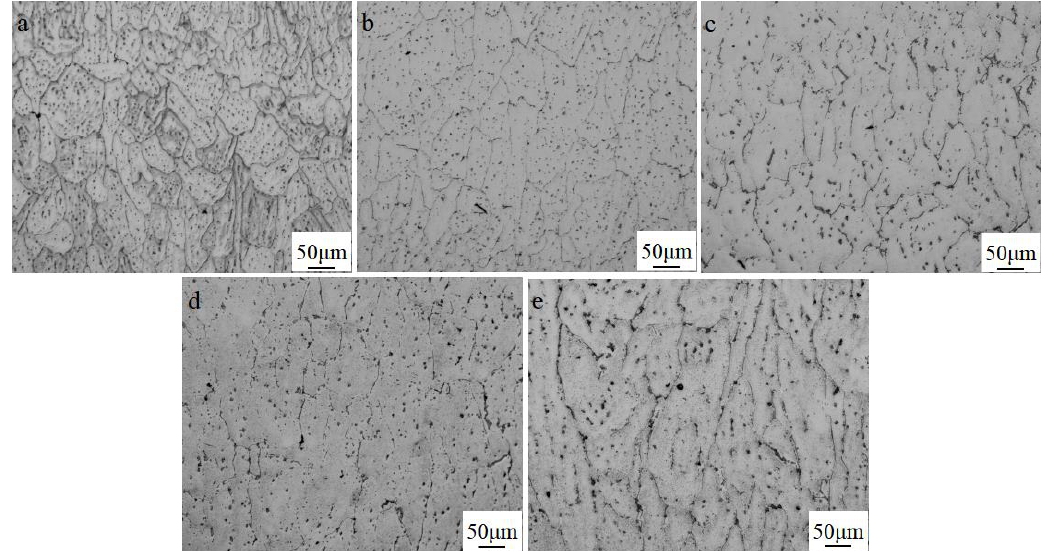
Figure 4. Microstructure of deposits with different heat input in as-deposited state. ( a ) 30 J/mm; ( b ) 60 J/mm; ( c ) 90 J/mm; ( d ) 120 J/mm; ( e ) 150 J/mm.